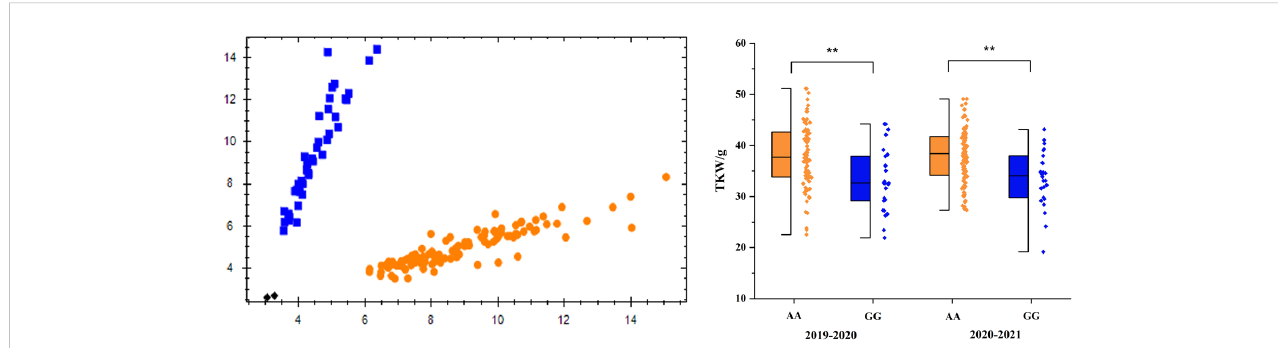
FIGURE 6 Genotype calling screenshots of the KASP markers. Blue indicates the G allele of Chilero, orange indicates the A allele of Avocet, and black indicates the blank control, **signi fi cant at p < 0.01. The same